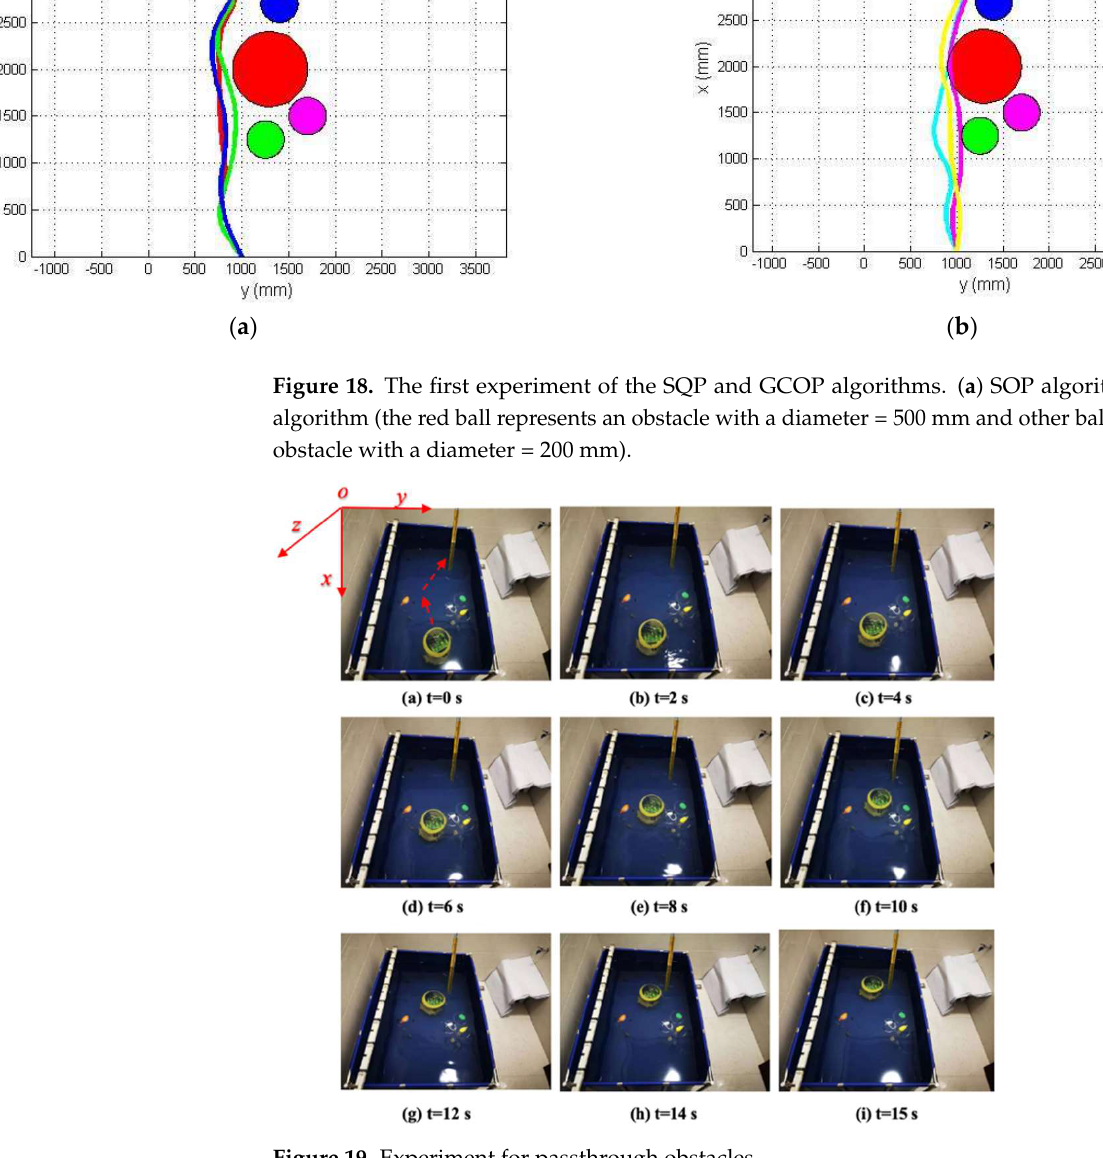
Figure 18. The first experiment of the SQP and GCOP algorithms. ( a ) SOP algorithm; ( b ) GCOP algorithm (the red ball represents an obstacle with a diameter = 500 mm and other balls represents an obstacle with a diameter = 200 mm).